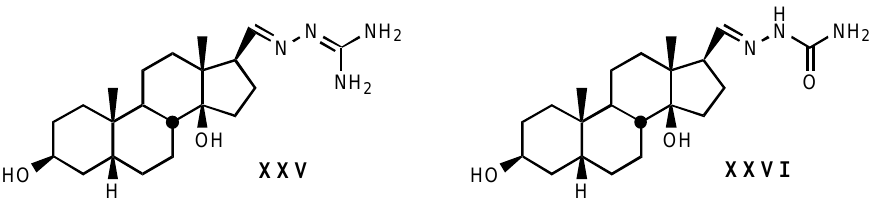
Figure 24. Structure of guanylhydrazone ( XXV ) and semicarbazone ( XXVI ) of digitoxigenin.